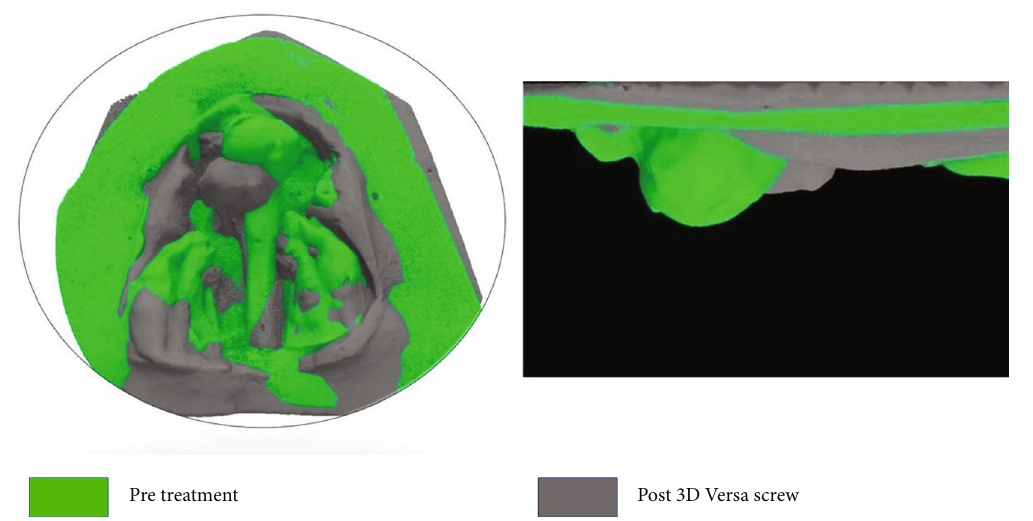
Figure 8: 3D Superimposition of models.